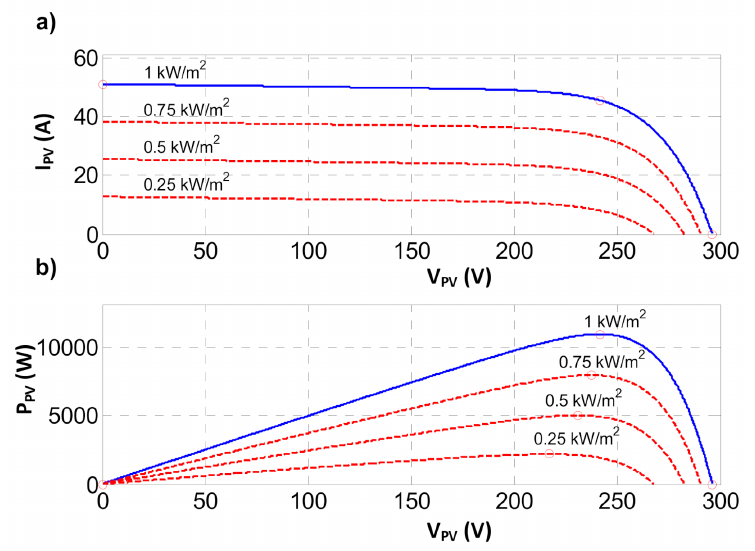
Figure 6. Computed current ( a ) and power characteristics ( b ) for the PV array at different levels of irradiation and fixed module temperature.